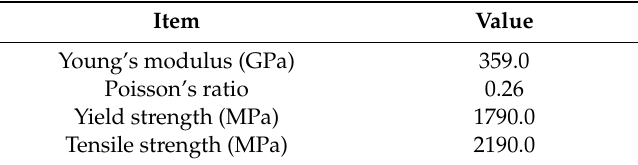
Figure 4 is the initial FE analysis model. DEFORM-2D software (Ver. 11.2, SFTC, Columbus , USA)